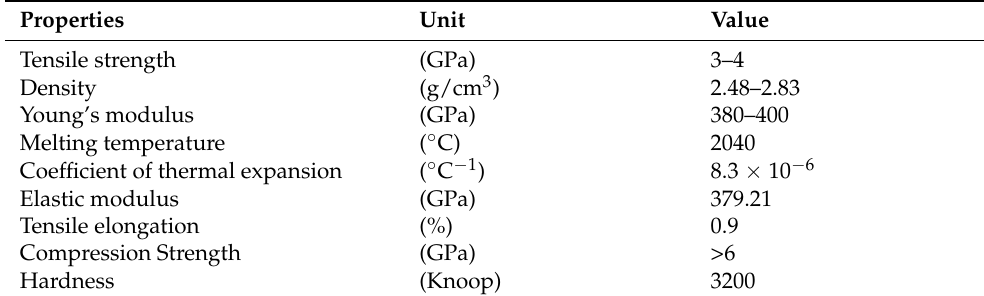
Figure 14. Main applications related to boron fiber. Table 8. Main properties of boron fiber